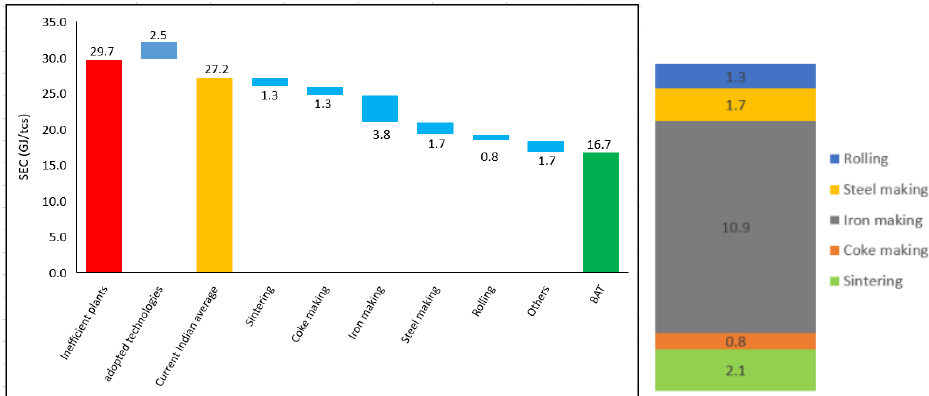
Figure 9. Specific Energy Consumption (SEC) and potentials for improved energy efficiency in BF-BOF route and breakdown of BAT (right) Reprinted with permission from TERI [31] Copyright 2020, The Energy and Resources Institute.